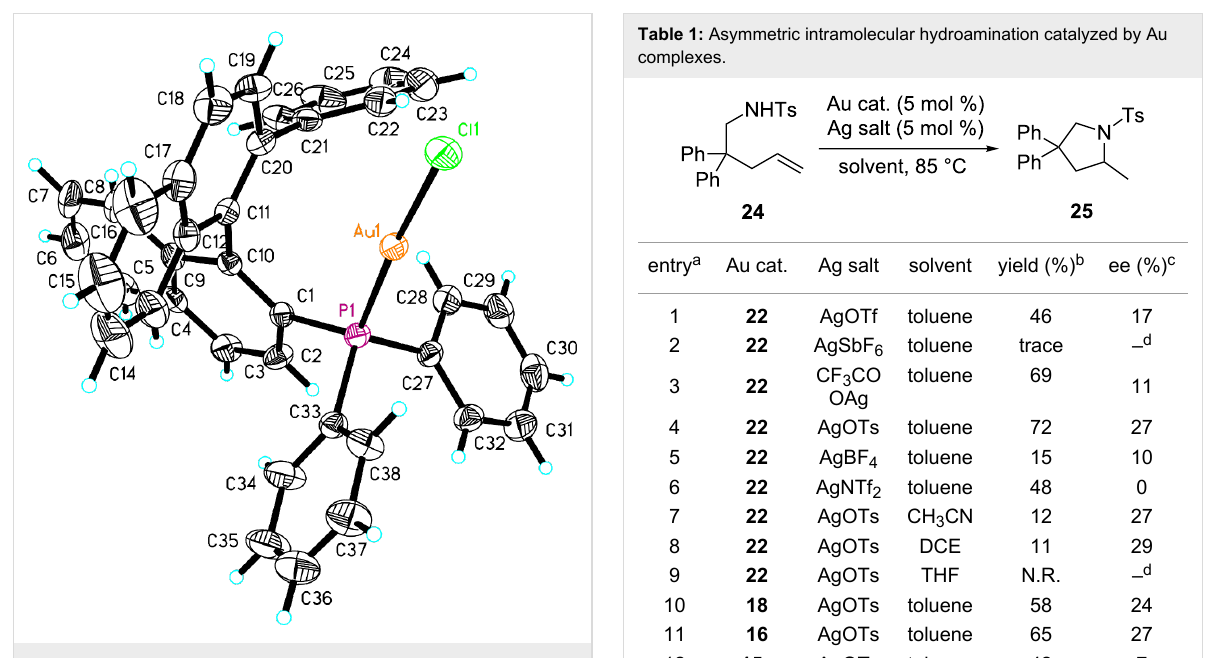
Figure 5: The crystal data of gold complex ( S )- 22 was deposited in the CCDC with the number 928664. Empirical formula: C 38 H 27 AuClP; formula weight: 746.98; crystal color, habit: yellow; crystal system: monoclinic; crystal size: 0.21 × 0.19 × 0.11; lattice parameters: a = 10.1476(9) Å, b = 15.7426(14) Å, c = 10.5615(9) Å, α = 90 o , β = 115.257(2) o , γ = 90 o , V = 1525.9(2) Å 3 ; space group: P 2(1); Z = 4; D calc = 1.626 g/cm 3 ; F 000 = 732; final R indices [I > 2sigma(I)]: R1 = 0.0231; wR2 = 0.0538.